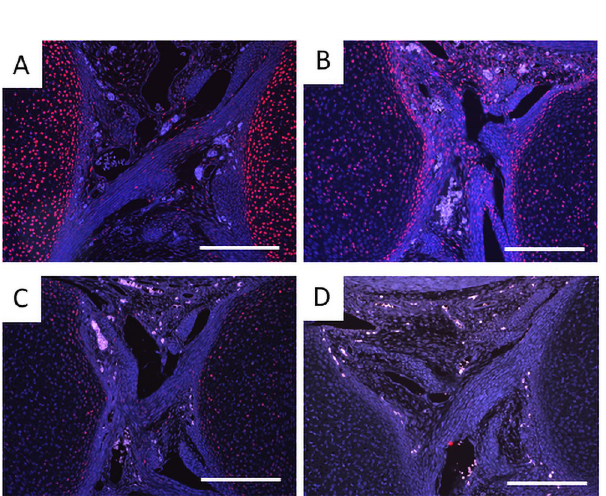
Fig 4. Scx immunostaining of newborn mouse knee joint. A. Prx1-Vcan +/+ mouse. Note that Scx is observed in articular chondrocytes and cells in the ligaments. B, C, D. Prx1-Vcan mouse. Note different immunostaining patterns. Scx is weakly immunostained at different levels (B, C, D) in articular chondrocytes (Bar = 200 μ m).